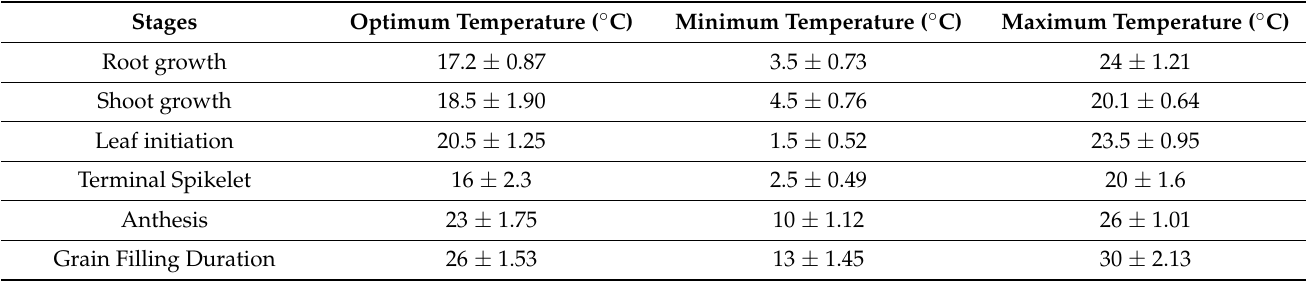
Table 1. Optimal temperature requirements of wheat at different growth